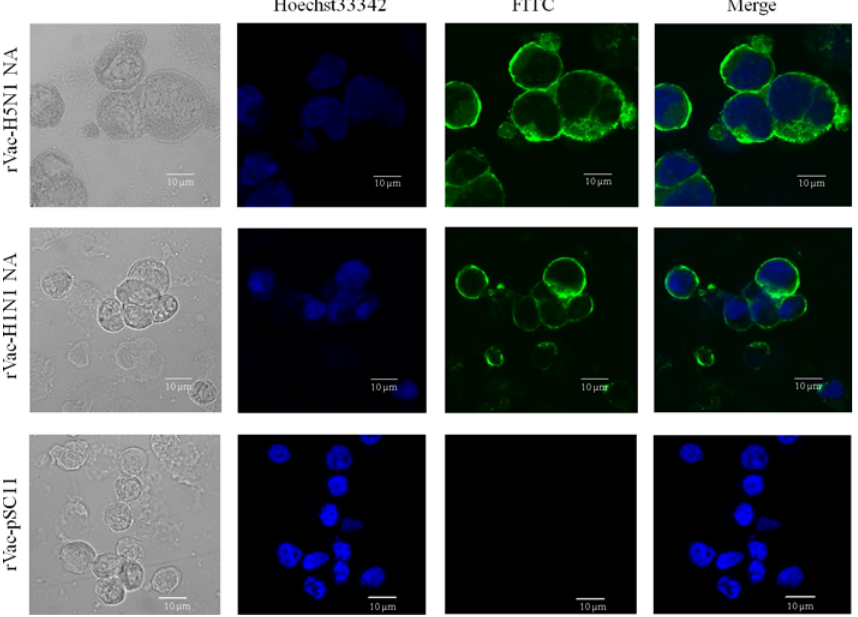
Fig 1. Cellular localization of NA proteins. The NA protein expressed in TK − cells infected with rVac-H5N1 NA or rVac-H1N1 NA are present in cytoplasm, and in particular, on the cytoplasmic membrane as demonstrated by IFA confocal microscopy. TK − cells infected with rVac-pSC11 as the virus control did not have a fluorescent